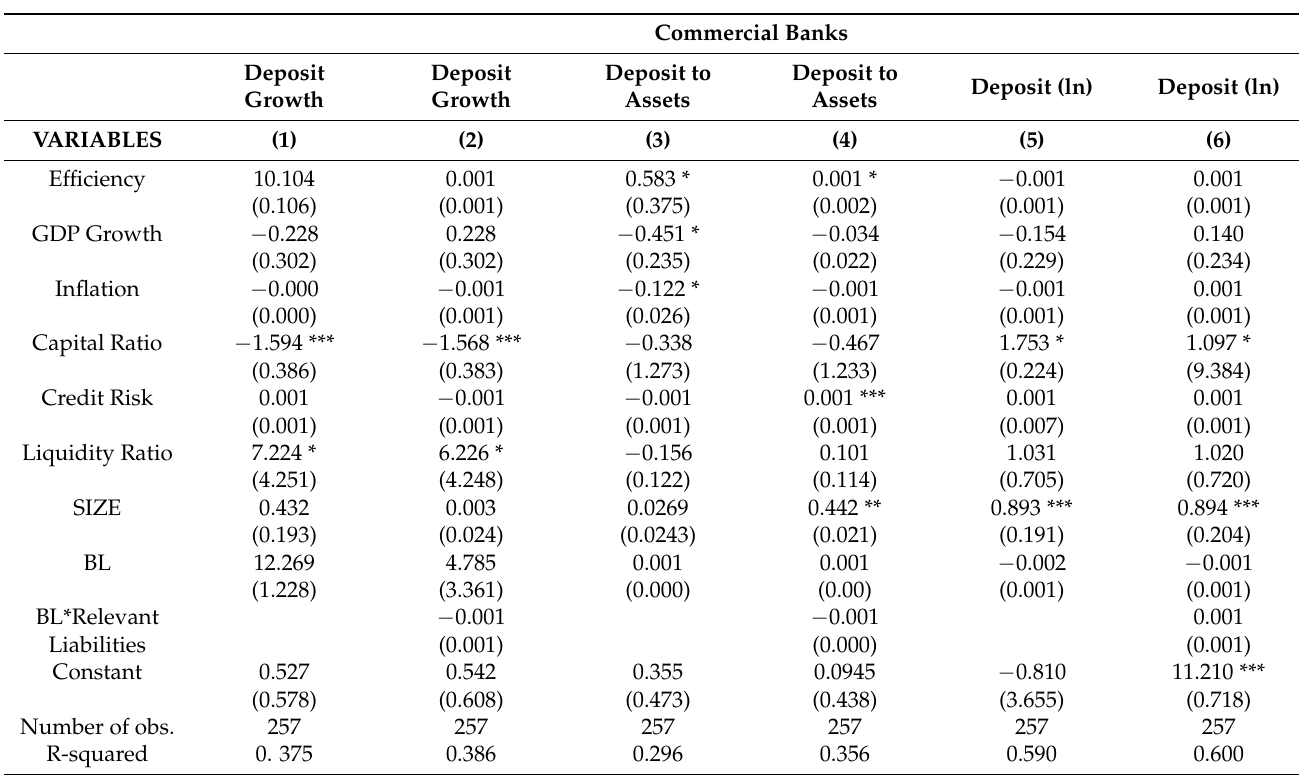
Table 8. Data presenting estimates based on GLS regressions with a random effect on all German commercial banks. Symbols *, **, and *** represent statistical significance at the levels of 10%, 5%, and 1%,